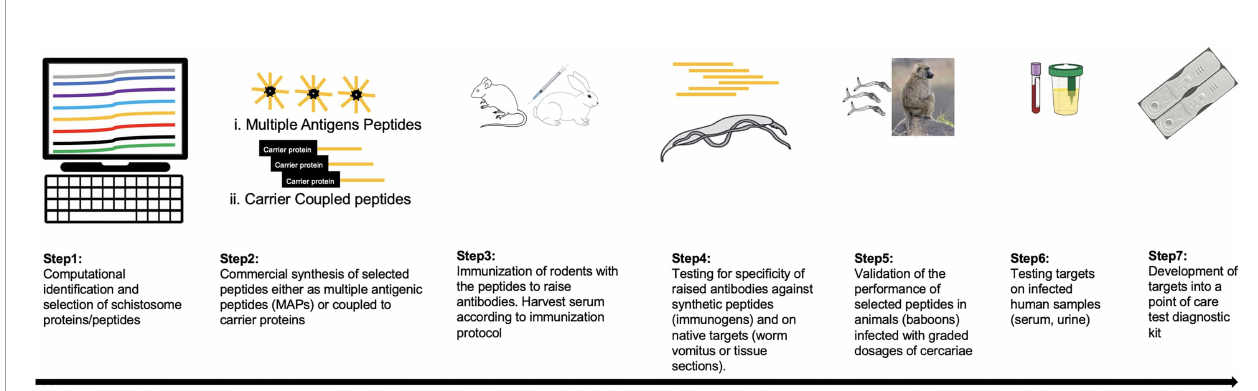
FIGURE 1 | A framework for the development of new diagnostic tagrets for schistosomiasis. Schistosome protein sequences are investigated to identify those that are present in host circulation. By computational approaches suitable peptides are selected based on prediction algorithms (step 1), the best hit candidates (depicted as orange in the fi gure) are commericially synthesised either as multiple antigenic peptides (MAPs) or conjugated to a carrier protein like ovalbumin (step 2). In step 3, mice/rats/rabbits are immunized with the synthetic peptides to raise antibodies according to the desired protocol. Serum samples are collected serially including pre-vaccination, during vaccination timepoints and after the fi nal dose. In step 4, antibodies in serum can be tested directly (polyclonal antibodies) or can be enriched for a preferred isotype, fi rst against the synthetic peptide or native target like worm vomitus for proteins from the schistomose gut in an ELISA format. For surface proteins, the nataive target can be schistosome tissue sections by immunohistochemistry. Step 5: Promising candidates are validated for sensitivity in larger animals (preferably the baboon model) where graded infections are possible to determine the limit of detection by comparing reactivity of serum to recovered worm burden. Step 6: Candidates are tested against serum and/or urine samples from individuals with con fi rmed schistosome infection. Finally, additional development steps are carried out to design the validated targets as rapid point-of-care diagnostic